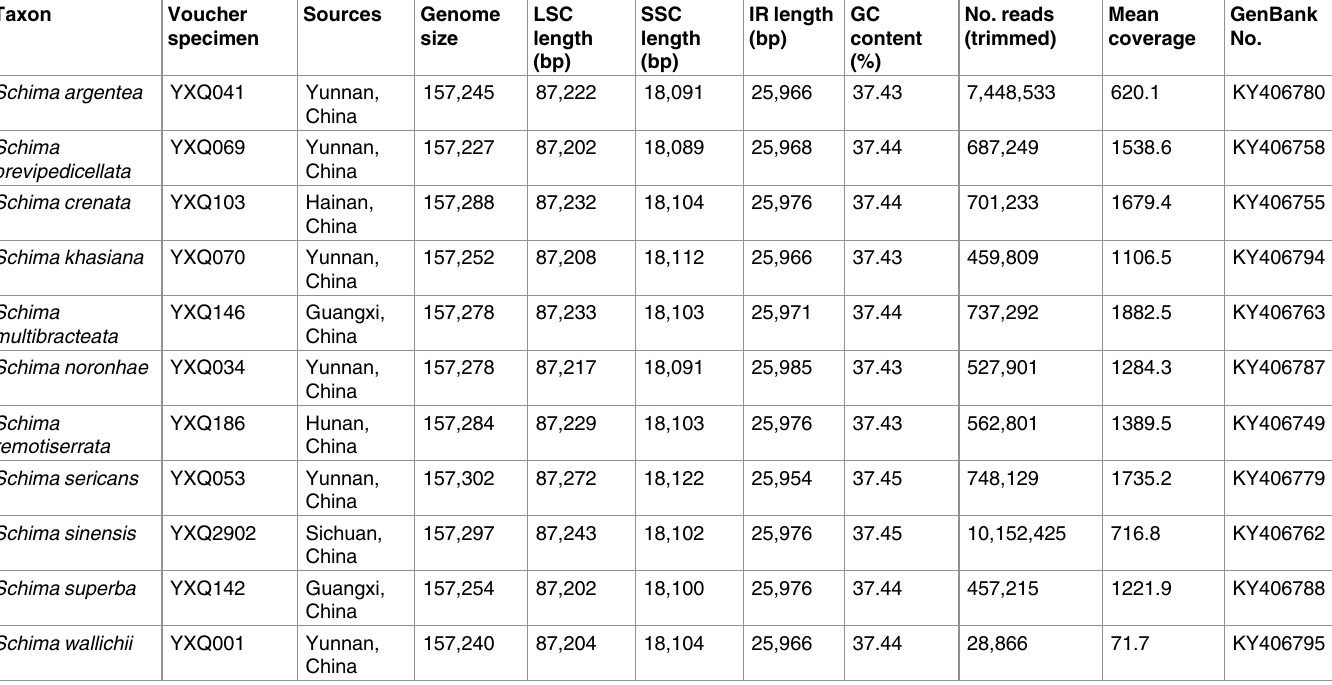
Table 1. List of taxa sampled in this study, with the voucher, chloroplast genome size, Illumina reads and coveragedepth information. Taxon Voucher